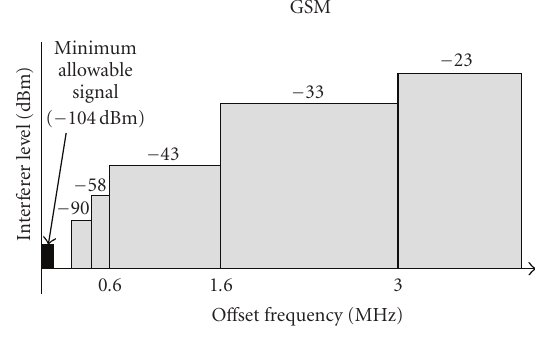
Figure 3: GSM receiver interference profile.